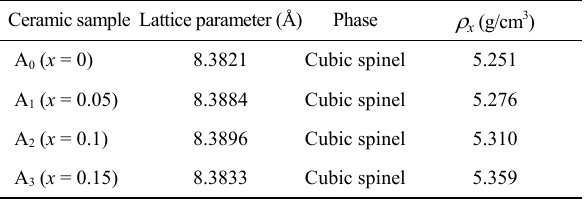
Table 1 Lattice parameter, crystal phase, and  x of A0, A1, A2, and A3 ceramic samples